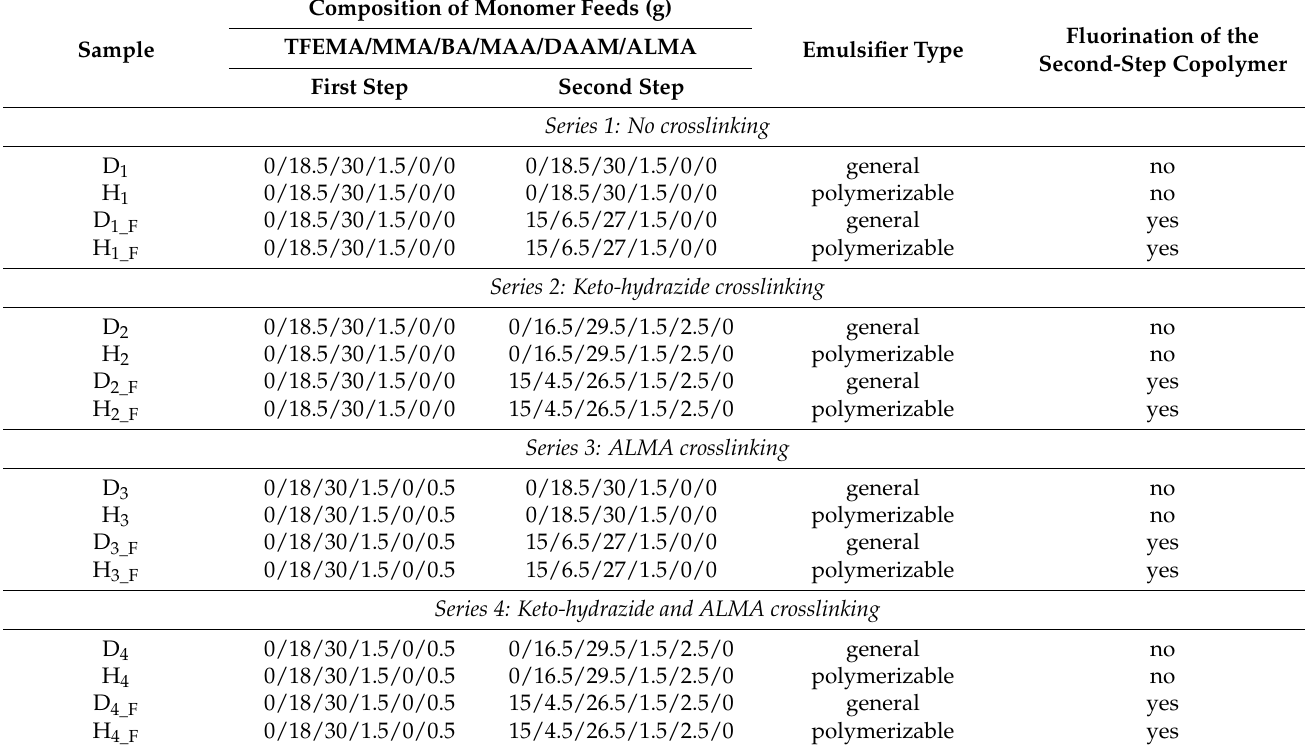
Table 2. Compositions of latexes differing in the fluorinated monomer copolymerization into the second-step polymer, emulsifier type, and covalent crosslinking strategy.